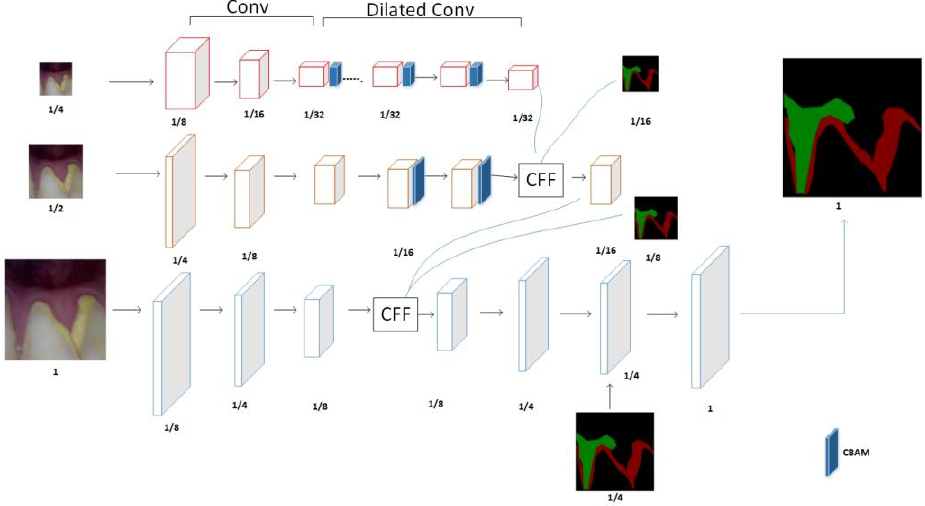
Figure 1. Improved ICNet network structure.